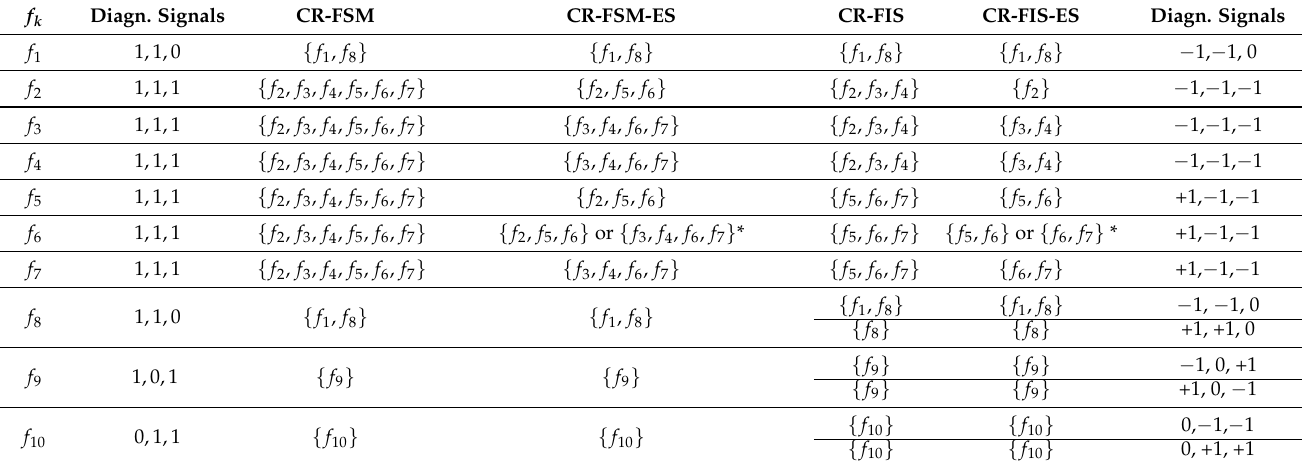
Table 13. List of diagnoses obtained by reasoning methods based on columns.